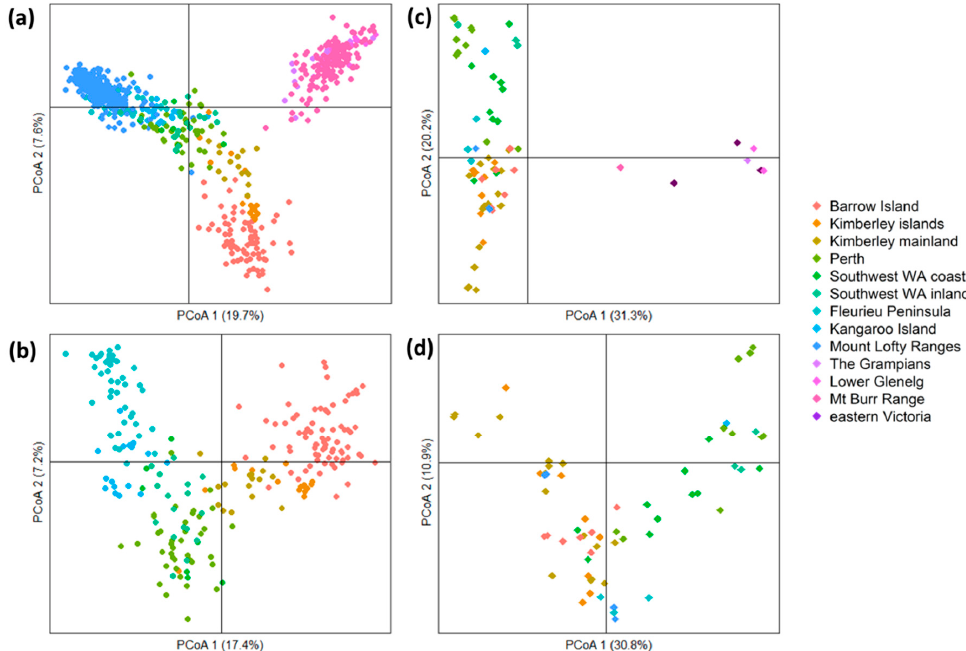
Figure 3. Stepwise principal co-ordinates analysis (PCoA) of allele frequencies based on ten microsatellite loci ( a , b ) and D-loop mtDNA haplotypes ( c , d ) including ( a , c ) and excluding ( b , d ) Victorian I. obesulus samples. Relative PCoA scores have been plotted for the first two dimensions (percentage variation explained on each axis). Individuals are represented in dots, and colours indicate sampling sites.